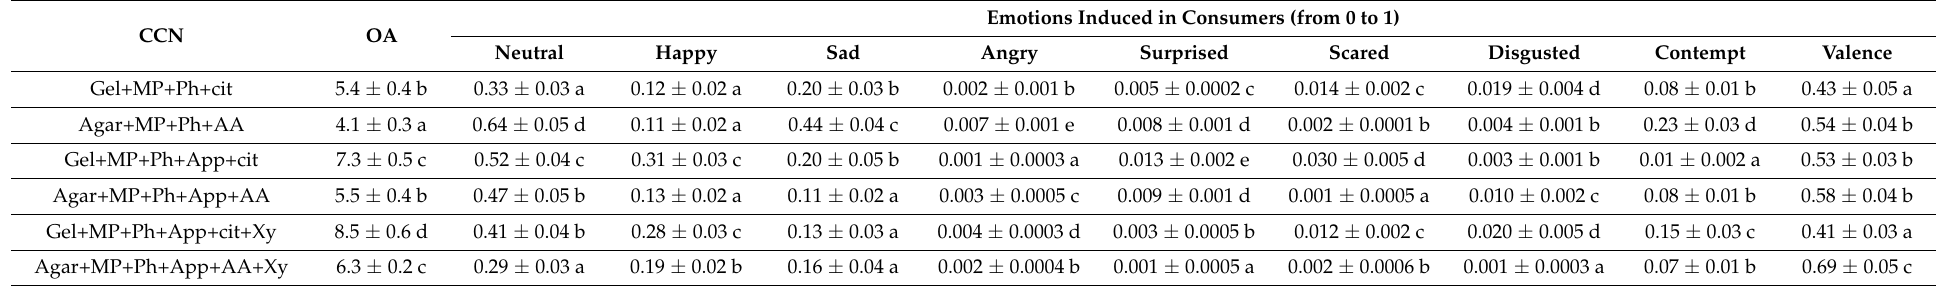
Table 3. Overall acceptability (OA) and emotions (EMs) induced in consumers by the prepared nutraceutical chewing candy